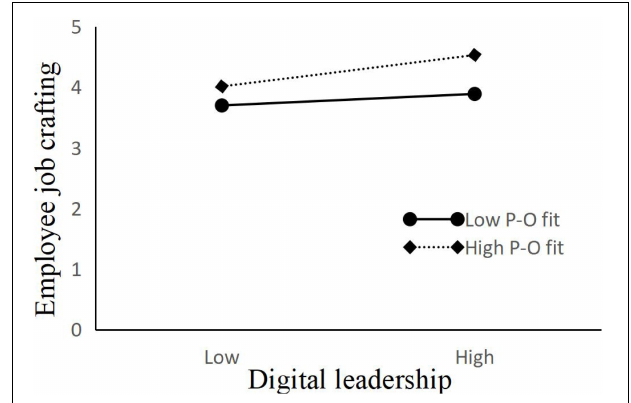
FIGURE 2 | Moderating effect of person-organization fit on the relationship of digital leadership and employee job